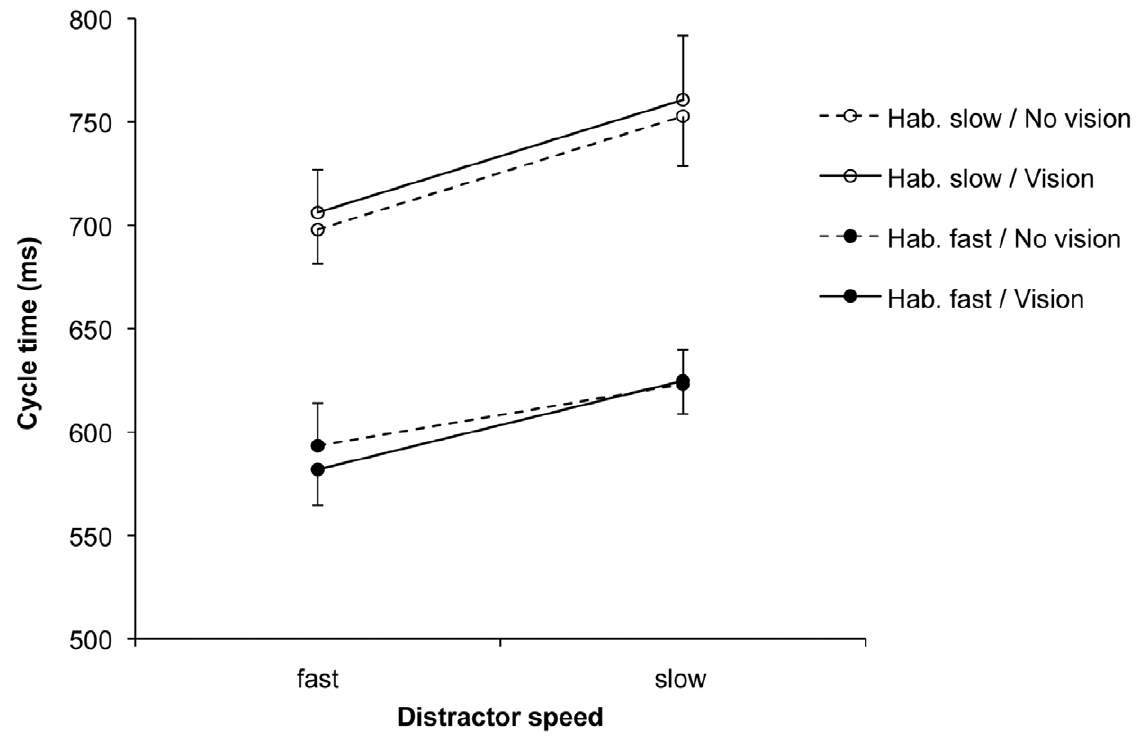
Figure 3. Automatic imitation experiment: Cycle times (ms). Mean cycle times for the factors habitual speed, distractor speed, and the availability of vision of the hand. The error bars show the standard error of the mean.